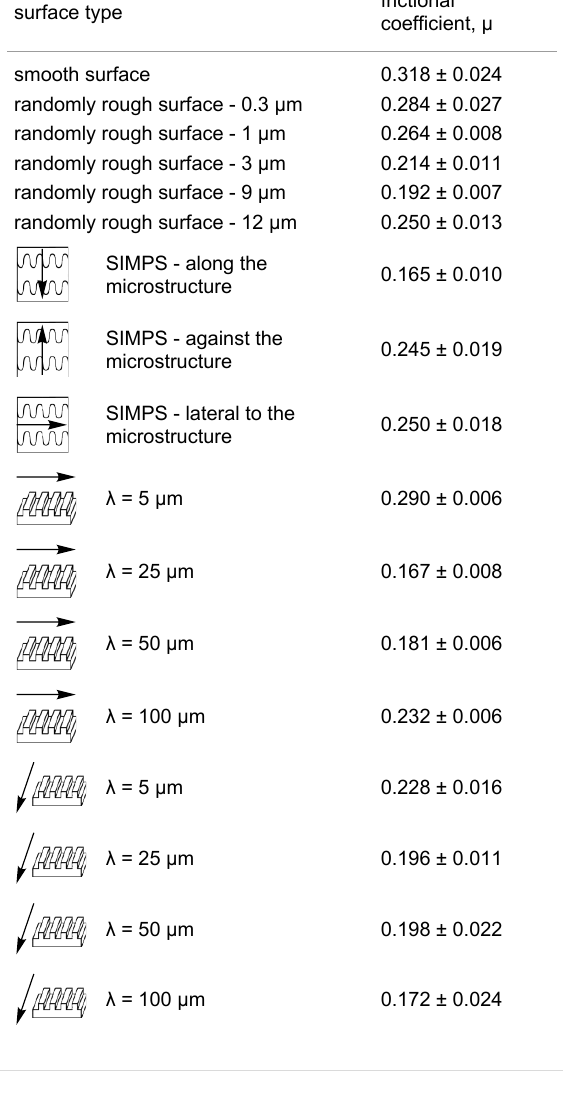
Table 6: Frictional coefficients (mean values and standard deviations) of all examined polymer surfaces. The arrows show the sliding direc- tions of each individual